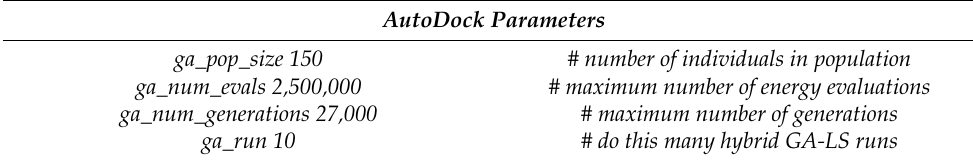
Table 8. AutoDock